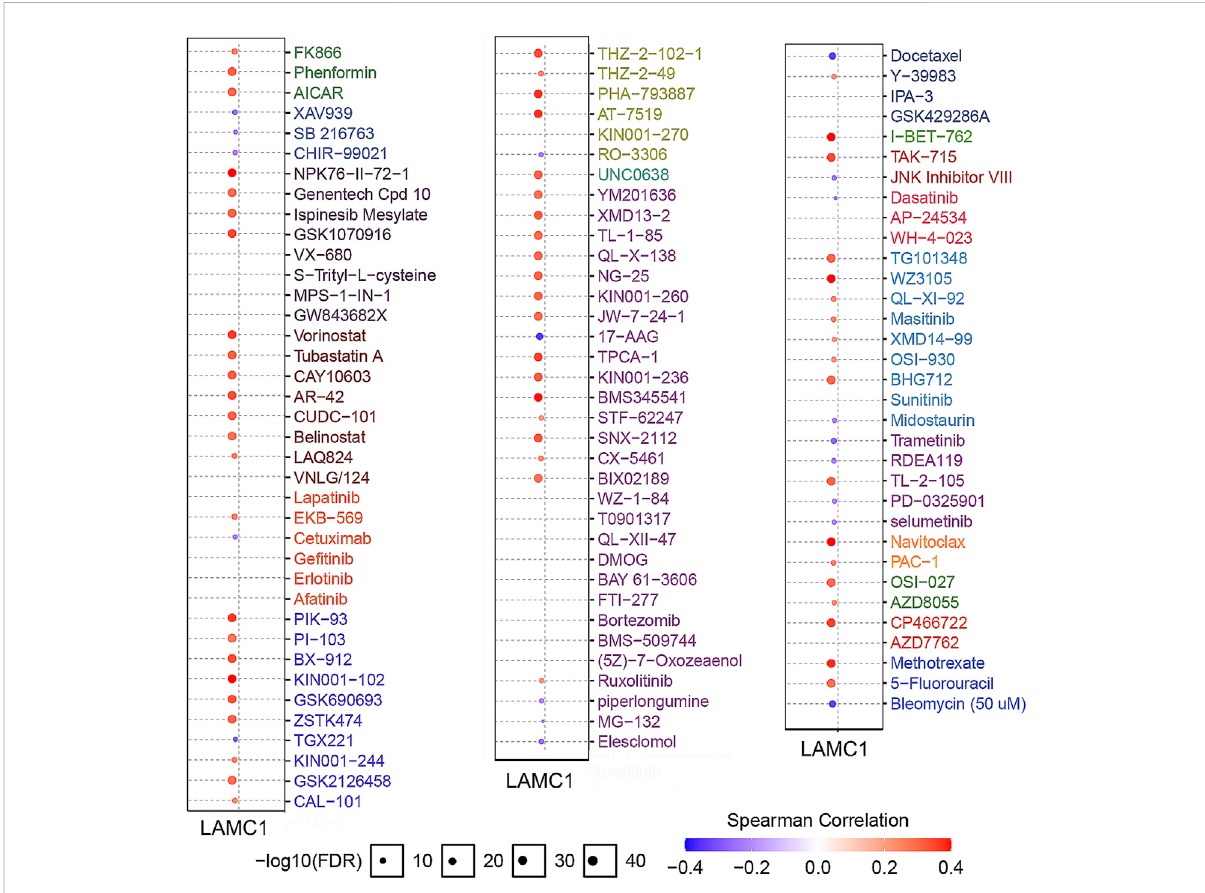
FIGURE 11 Analysis ofdrugresistancebasedon IC50drug datafromtheGDSCdatabase(GSCALite).Apositive Spearman correlation (red)meansthathigh gene expression correlates with drug resistance, a negative Spearman correlation (blue) means that low gene expression correlates with drug